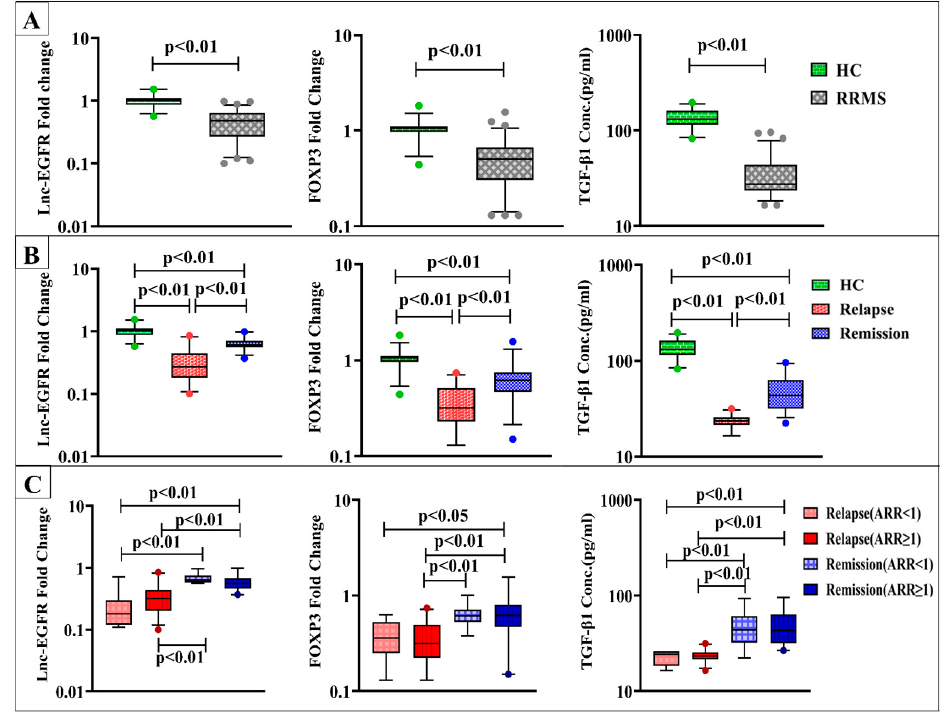
Figure 1. Expression levels of lnc-EGFR and FOXP3 and serum TGF- β 1 levels in ( A ) healthy controls (HC) (n = 30) and RRMS patients (n = 70), ( B ) HC (n = 30), RRMS patients during relapse (n = 35), and RRMS patients in remission (n = 35), and ( C ) RRMS patients during relapse and in remission with ARR < 1 (n = 7), (n = 16) and ARR ≥ 1 (n = 28), (n = 19) respectively. Box plots show the median as a band inside each box, while boxes and whiskers delineate 25–75th and 10–90th percentiles, respectively. Dots outside the whiskers indicate outliers. Significant p -values are indicated on graph at p < 0.01.